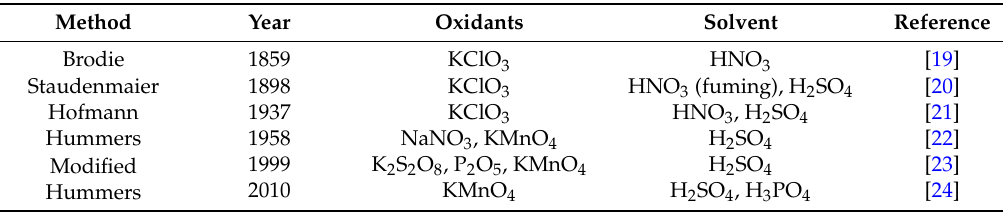
Table 1. Summary of GO synthesis